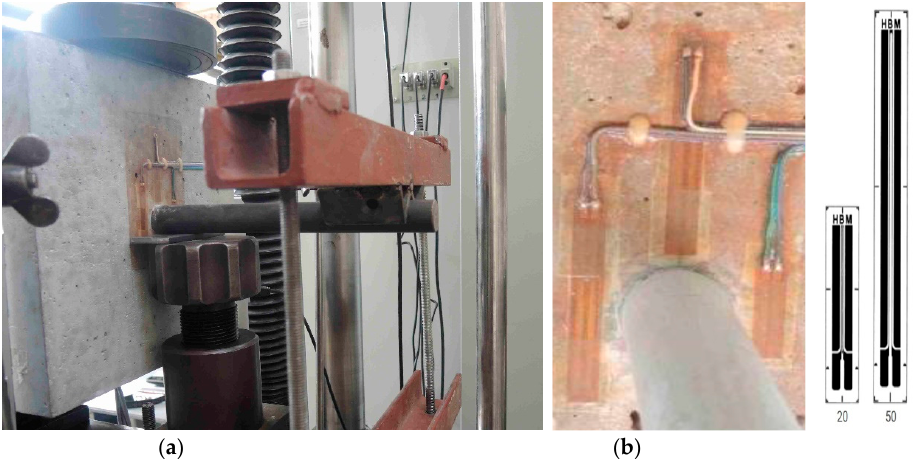
Figure 3. ( a ) Loading test of beam “B” and ( b ) applied strain gauges of 50 and 20 mm.